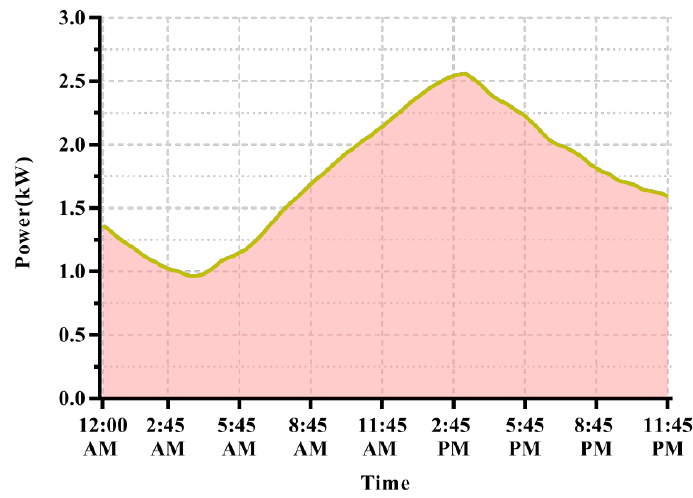
Figure 5. Electric load (i.e., baseload) profile of a typical